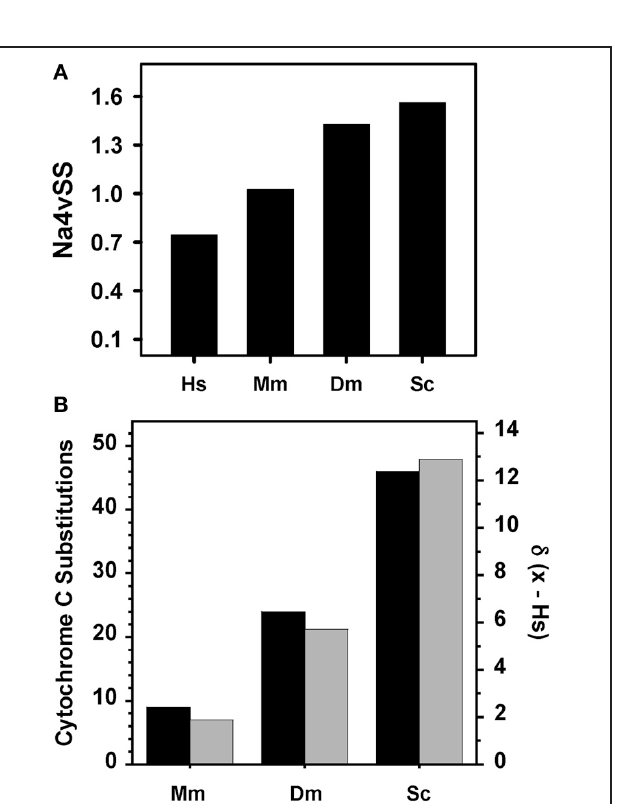
FIGURE 2 | Relationship between organism complexity and aggregation properties of kinase domains. (A) Average aggregation propensity (Na4vSS) for the complete dataset of kinome domains of human ( Hs ), mouse ( Mm ), fruit fly ( Dm ), and budding yeast ( Sc ). (B) Deviation in the distribution of aggregation prone domains (Na4vSS > 0) between human and the rest of species (gray, calculated according to Equation 1) compared with the number of amino acid differences in cytochrome c between human and other species